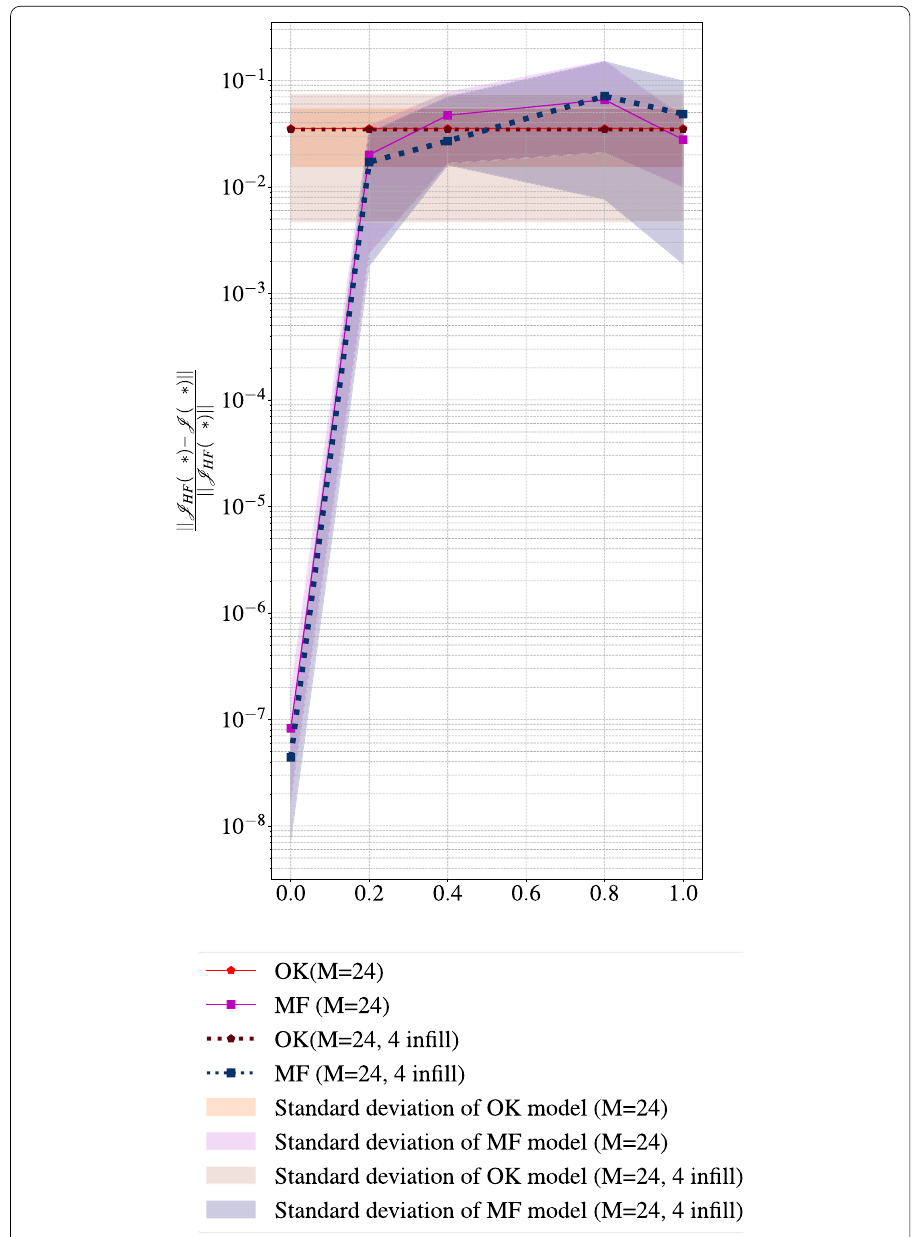
Fig. 10 Evolution of the relative error for enriched and random DoE for multiple runs